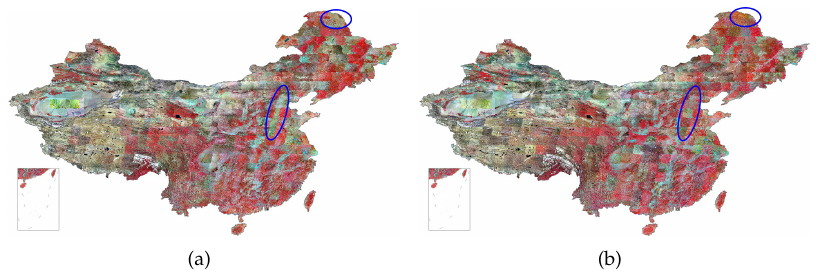
Figure 3. Original Landsat 5 Level 1T images of China (pseudo-color combined of NIR, red and green bands). ( a ) 2005; ( b )